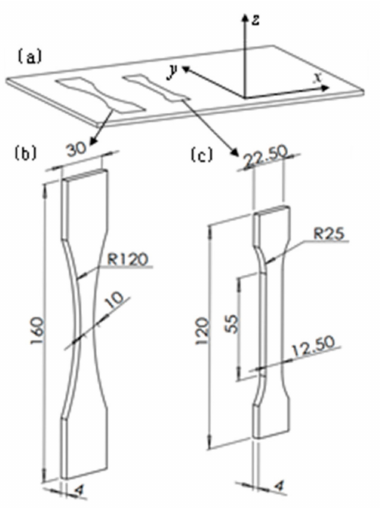
Figure 2. Size of the specimens: ( a ) cutting direction, ( b ) high cycle fatigue (HCF) specimen, and ( c ) tensile specimen (unit: